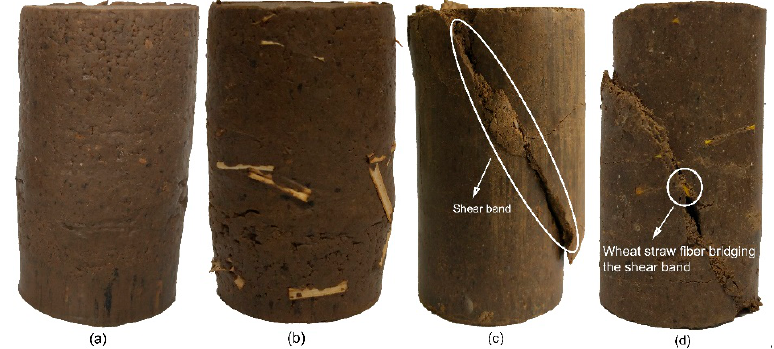
Figure 6. Photographs of sample failure patterns (at a 20% axial strain level) in triaxial compression tested at σ 3 = 200 kPa: ( a ) untreated soil, ( b ) 0.4% fiber-reinforced soil, ( c ) 4% lime-stabilized soil, and ( d ) 0.4% fiber-reinforced soil stabilized with 4% lime.